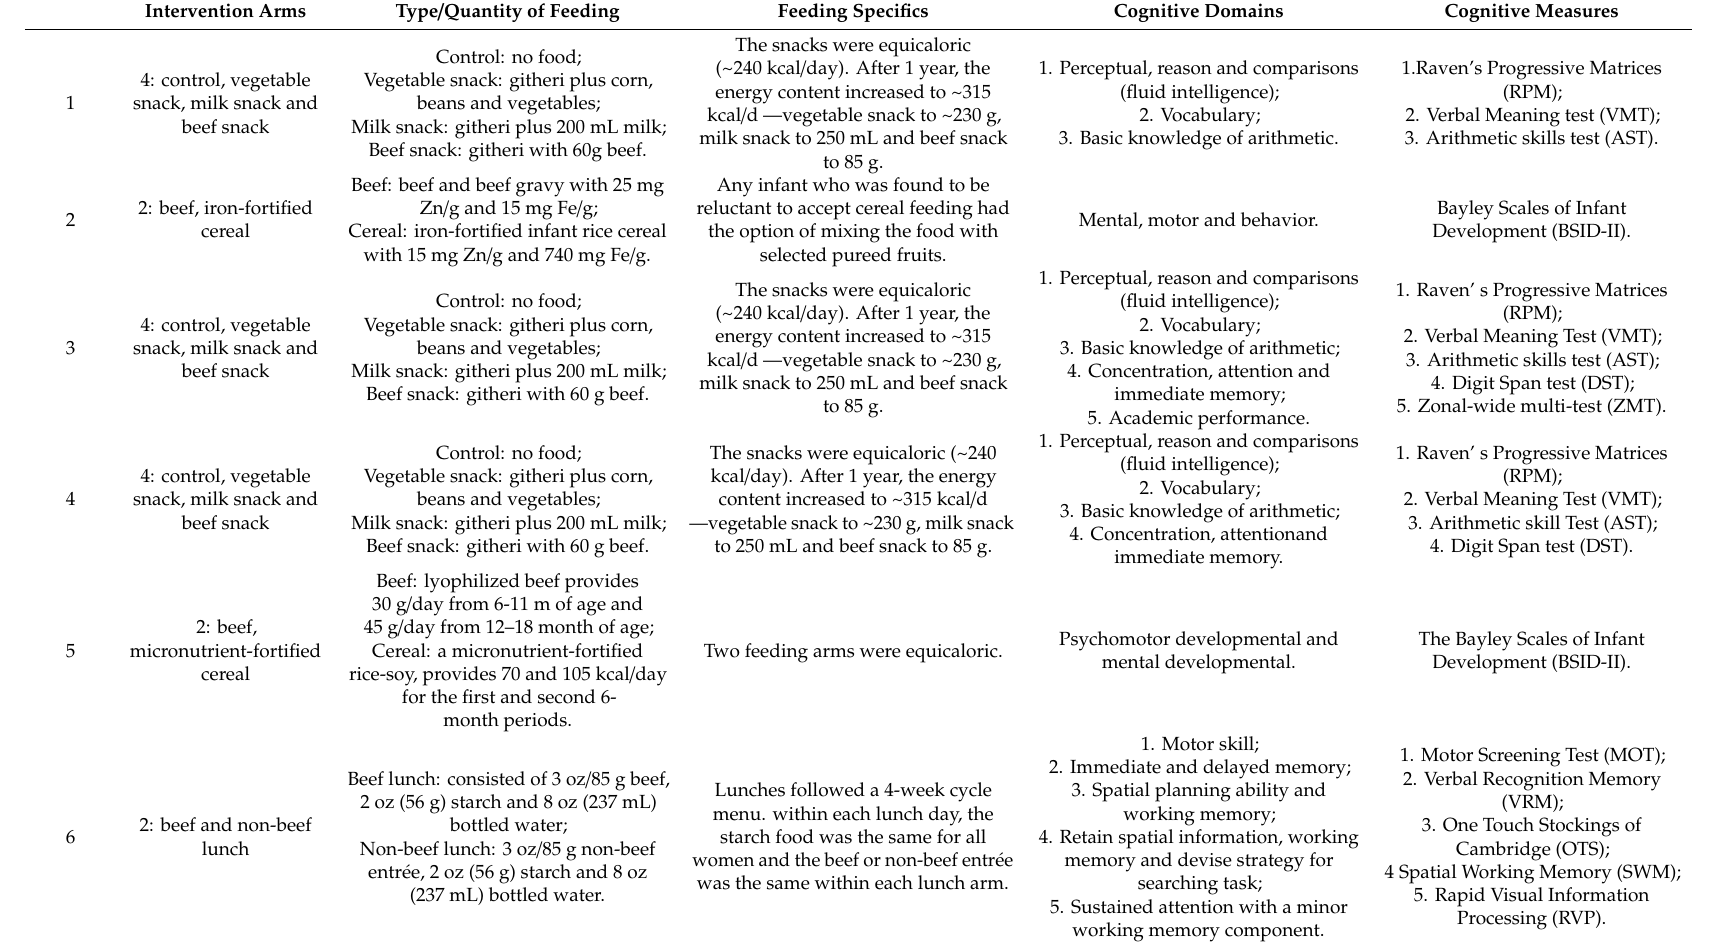
Table 2. Intervention arms, feeding methods and cognition